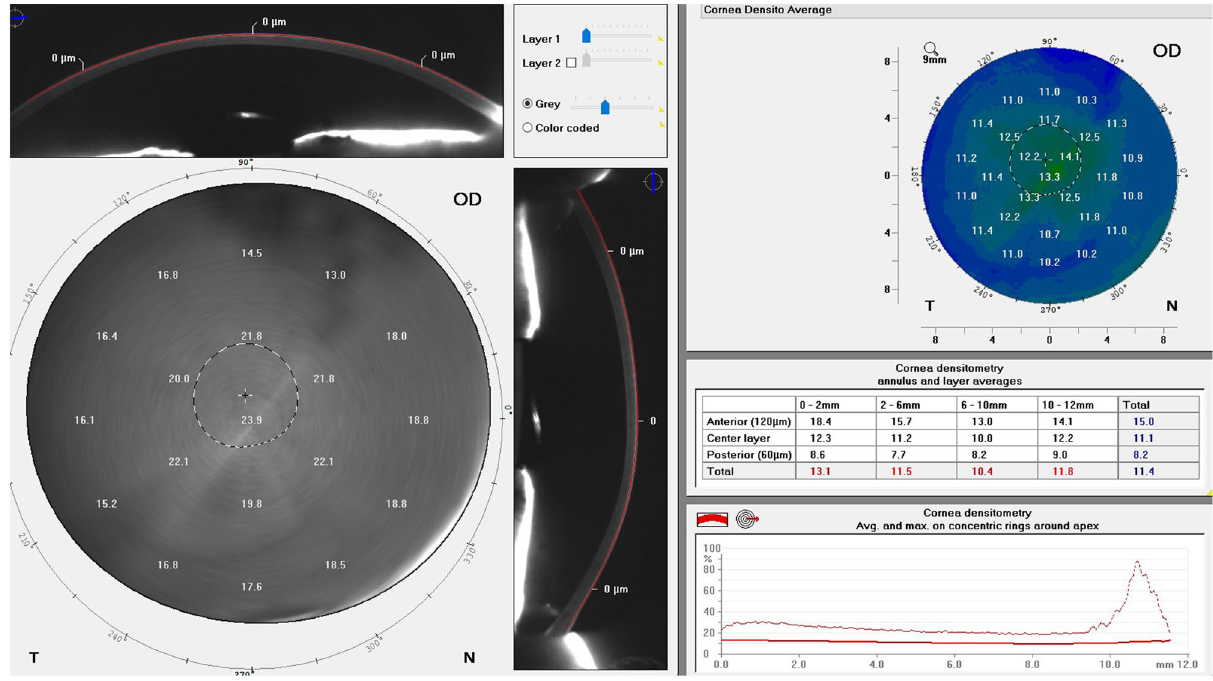
Figure 1. Image of the densitomtry module in the Pentacam